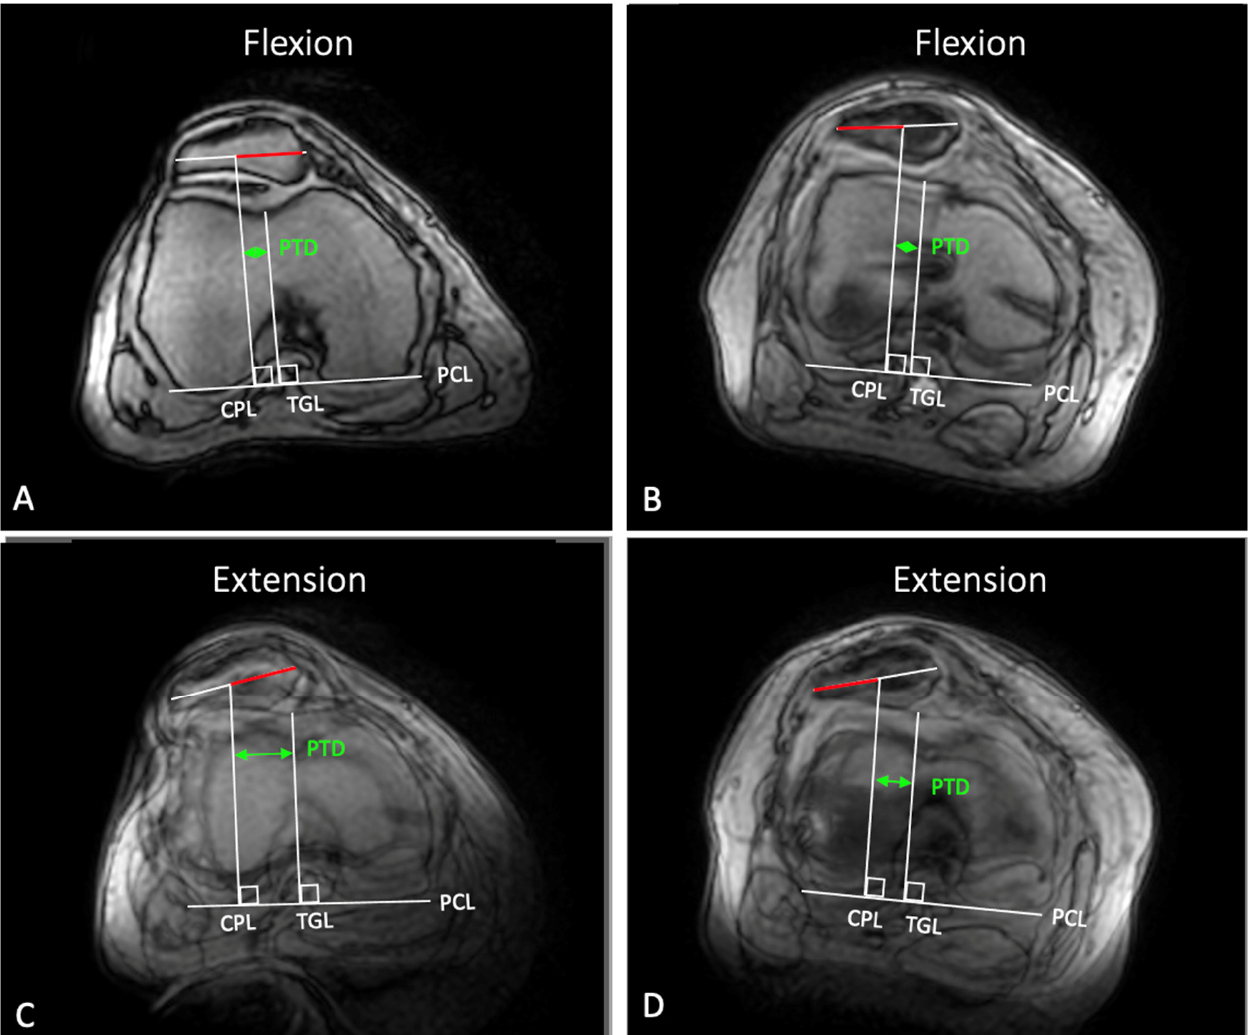
Figure 7. Correction of patellar maltracking in a right knee, caused by a femoral torsional deformity ( − 41° according to Waidelich et al. [41] ). Preoperatively, the patellotrochlear distance (PTD) was 2.8 mm in 40° of flexion ( A ) and 16.6 mm in full extension ( C ), which resulted in a dynamic mediolateral patellar translation (dMPT) of 13.8 mm. Further, a dynamic patellar tilt (dPT) of 11° was found. After, torsional distal femoral osteotomy (DFO) and MPFL reconstruction, the PTD in flexion re- mained almost unchanged ( B ), but changed to 8 mm in full extension ( D ). Accordingly, a postoper- ative dMPT of 5 mm and a dPT of 6° was observed.